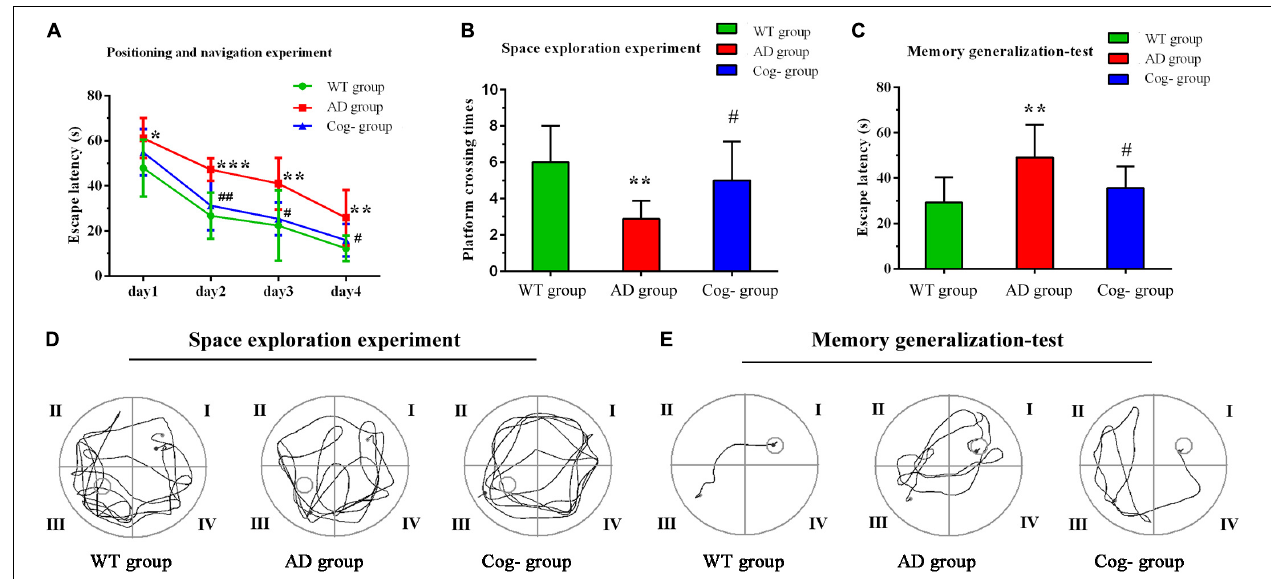
FIGURE 3 | Cognition performance after cognitive training in APP/PS1 mice. (A–E) Learning memory and memory generalization ability after cognitive training. (A) The escape latency of each group in the Morris water maze. (B) The escape platform crossing times of each group in the Morris water maze. (C) The escape latency of each group in the memory generalization test. (D) Representative diagram of each group in the space exploration experiment. (E) Representative diagram of each group in the memory generalization test. * P < 0.05 compared with the WT group, ** P < 0.01 compared with the WT group, *** P < 0.001 compared with the WT group, # P < 0.05 compared with the AD group, ## P < 0.01 compared with the AD